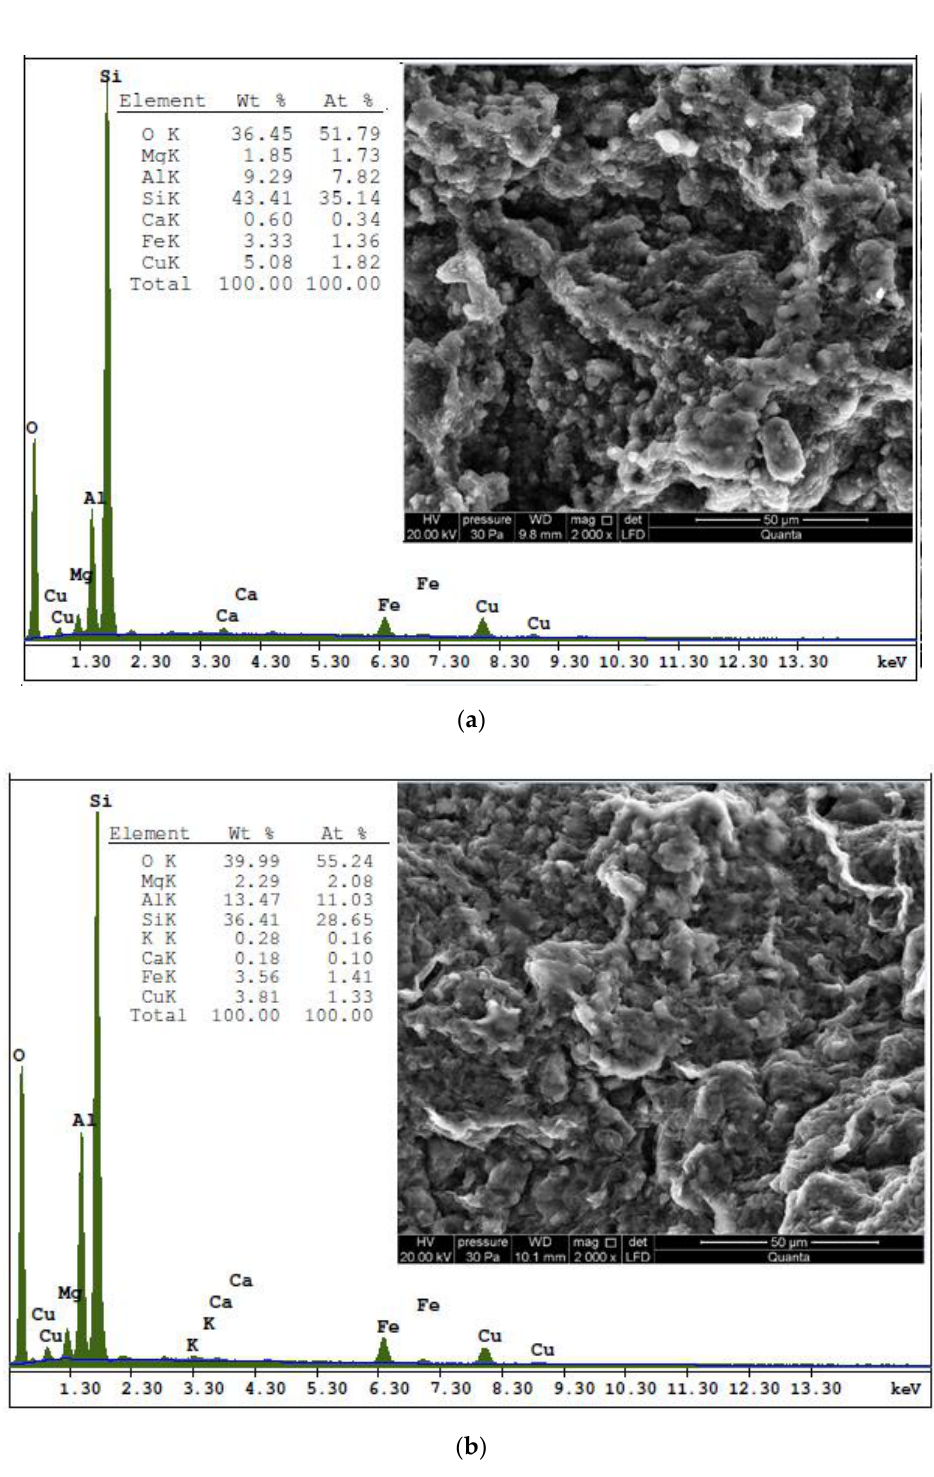
Figure 1. Morphology and SEM-EDX data of the bentonite samples after ‘Cu’ treatments: ( a ) Stx-1b from Texas, ( b ) BSvk from Slovakia.